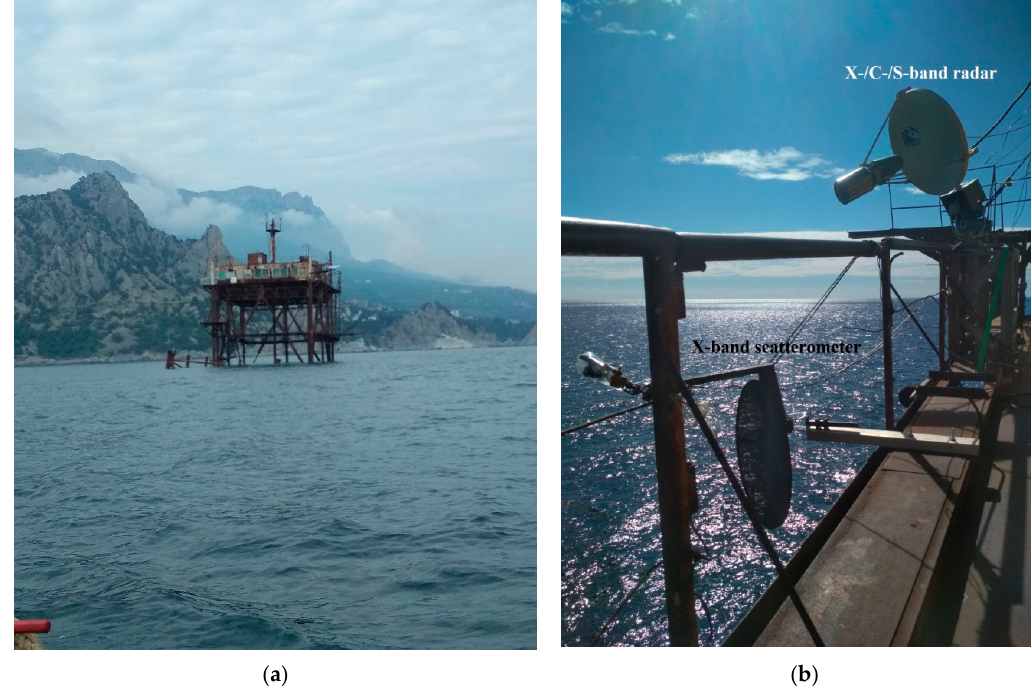
Figure 2. ( a ) Oceanographic platform and ( b ) the X-band scatterometer and the X- / C- / S-band radar mounted on the platform.